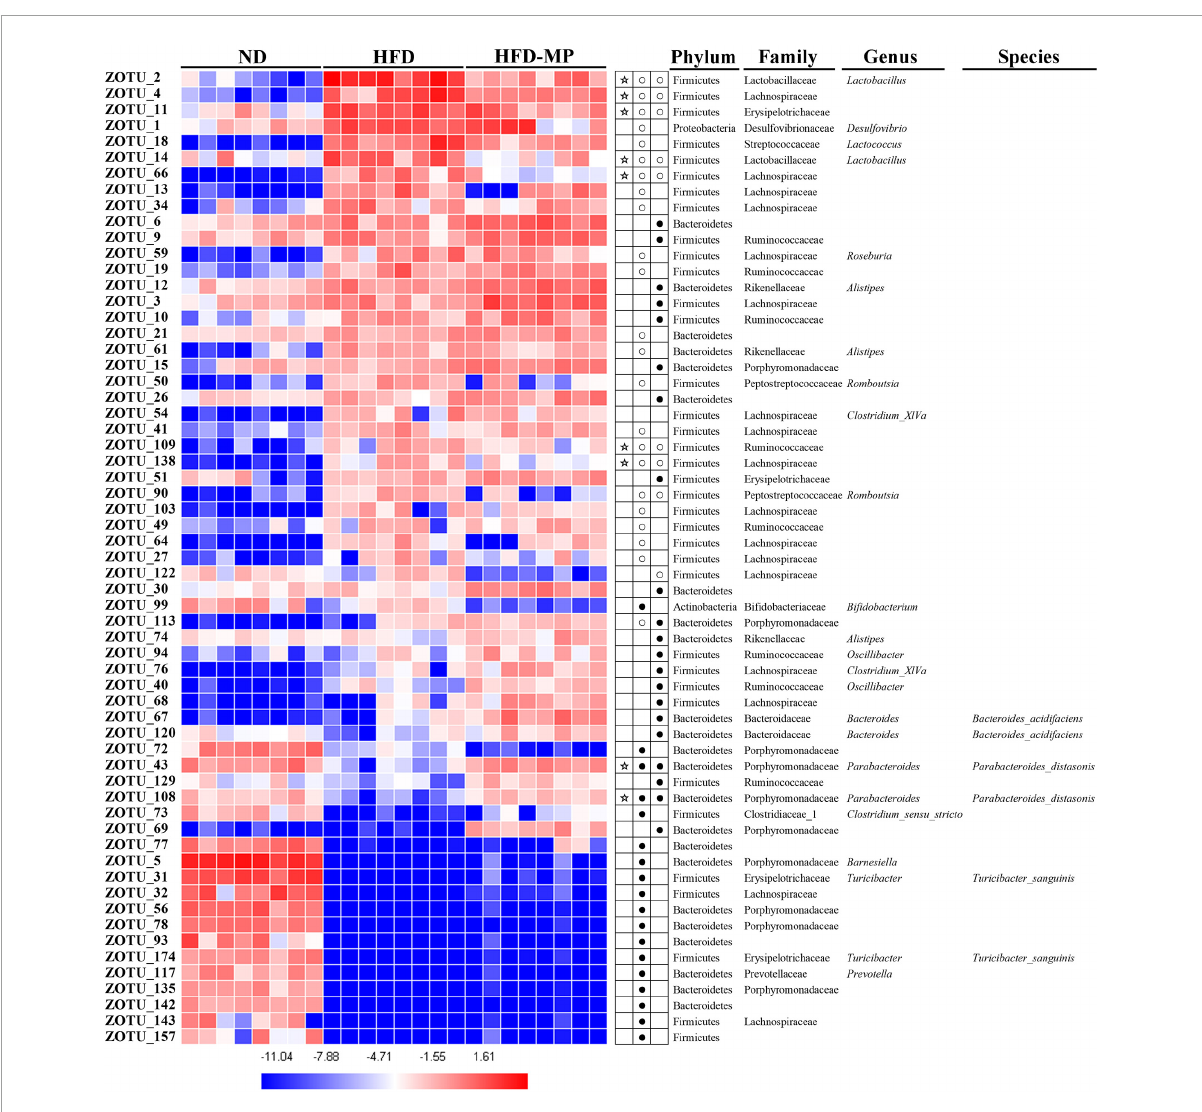
FIGURE7 Gut microbiota composition was altered by HFD or MP intervention at the ZOTUs levels. Heatmap shows the relative abundance of 62 ZOTUs (ln transformed). The dots ( ) and circles ( ) showed the more or less relative abundances of ZOTUs in ND or MPs groups compared with the HFD group. The star ( ) represented ZOTUs changed by HFD but were reversed after treatment with MPs. Statistical differences were carried out by one-way ANOVA followed by Tukey’s test, p < 0.05 indicates significant